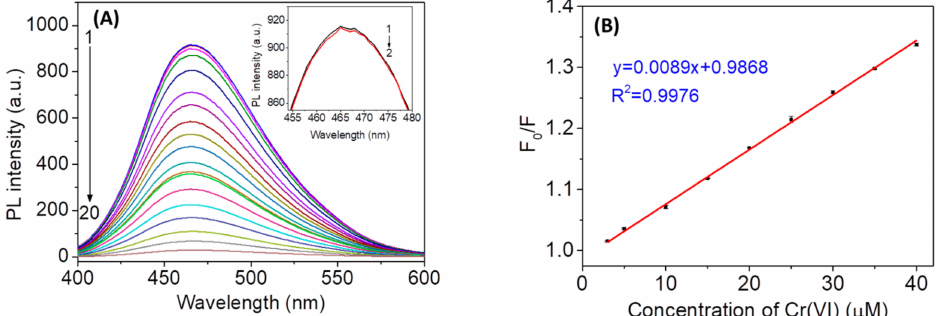
Figure 5. ( A ) Fluorescence quenching of N , Cl -CDs in the presence of different concentrations of Cr(VI). 1–20: 0, 0.93, 1.67, 4.17, 10, 20, 30, 40, 50, 60, 70, 80, 90, 100, 120, 150, 180, 230, 290, and 360 µ M; the